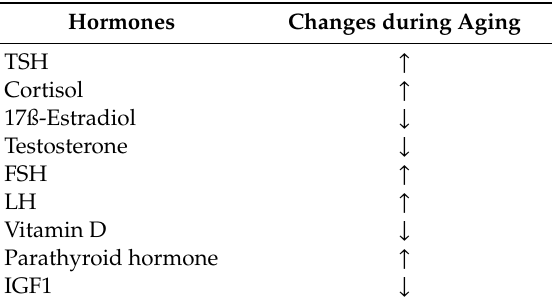
Table 2. The main hormonal changes in the